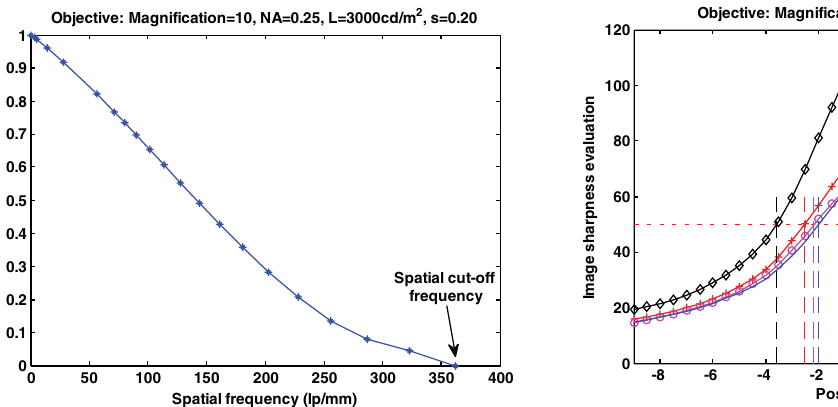
Fig. 8. The measured image sharpness versus focusing positions under the 40 × objective and different s values: 0.6, 0.8, 1.0, and